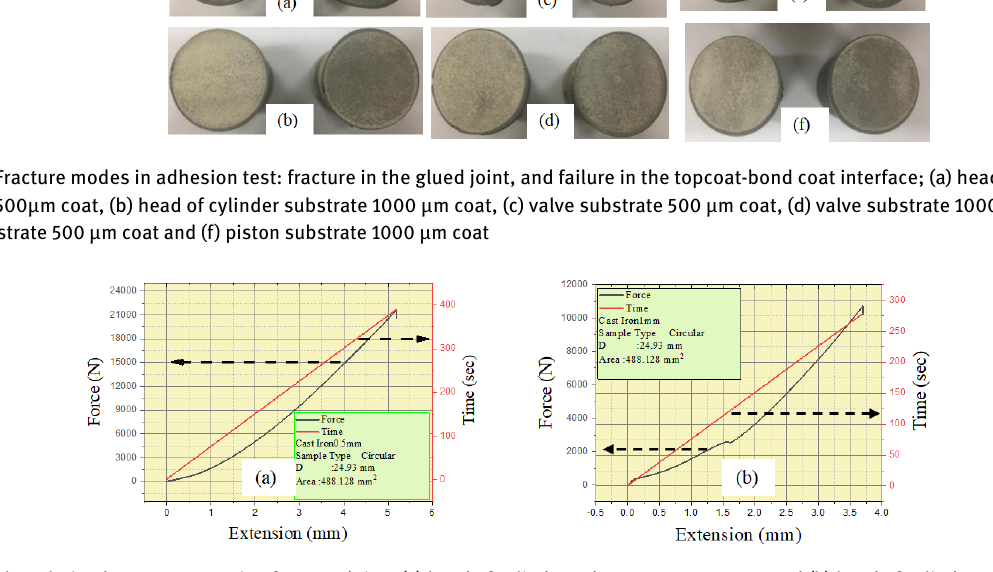
Figure 16: The relation between extension force and time (a) head of cylinder substrate 500 µ m coat and (b) head of cylinder substrate 1000 µ m coat